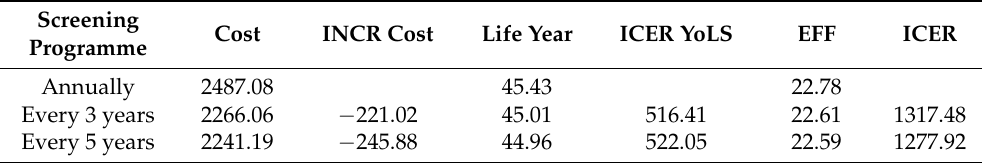
Table 3. The result of base-case cost-effectiveness analysis. QALY, quality-adjusted life-year; EFF: effectiveness; ICER: incremental cost-effectiveness